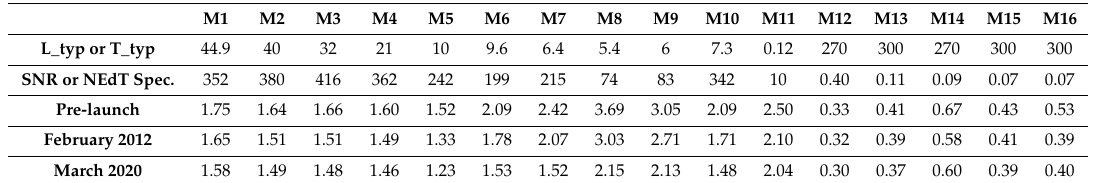
Table 3. S-NPP VIIRS SNR and NEdT requirements at specified typical radiances (M1-M11) and